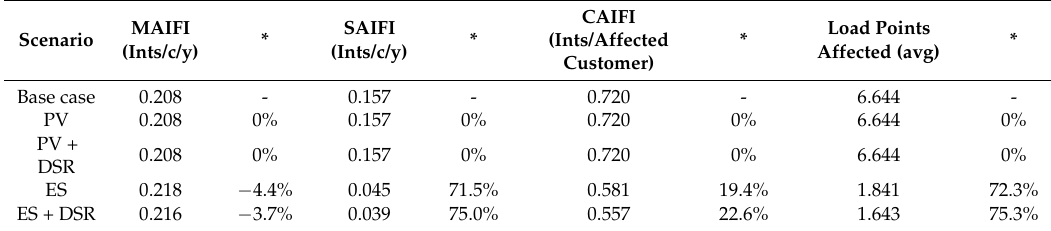
Table 3. Frequency of long and short